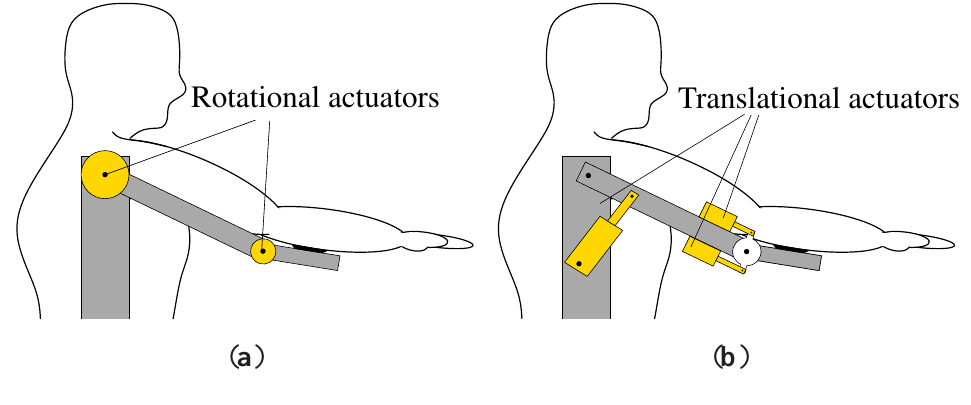
Figure 2. Schematic examples of directly on the joint actuation configuration for ( a ) rotational and ( b ) translational.